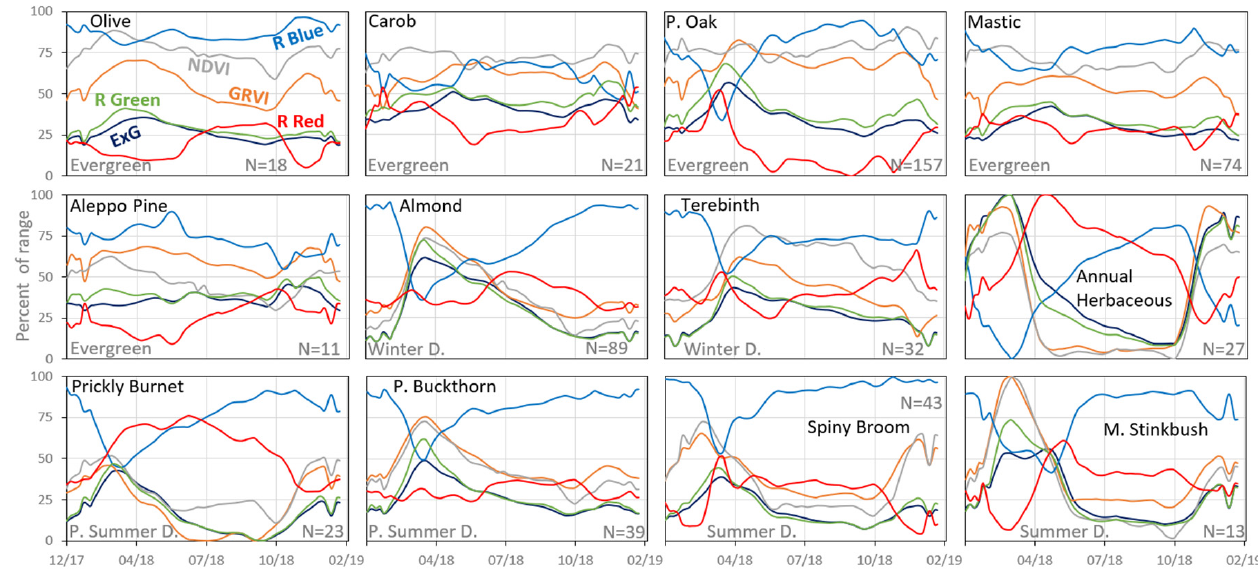
Figure 6. Mean values of the six vegetation indices for 12 species based on the ground photos after preprocessing. The y - axis represents the standardized mean value of the vegetation index as a percent of the range of its values (12 species in 57 dates, i.e., one year, per index, min and max values in Table S1), to ease comparison across the species and between the indices.